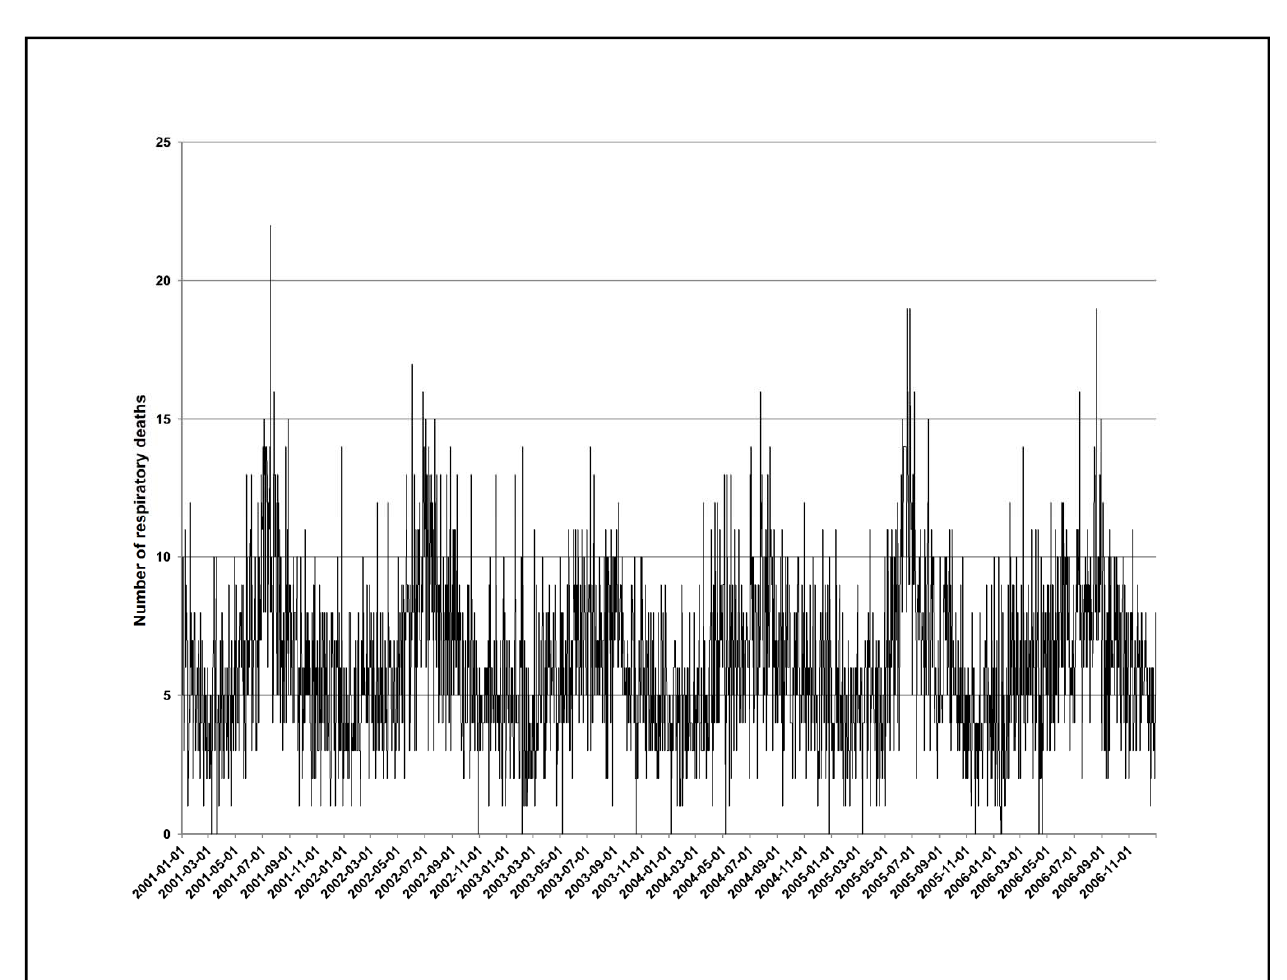
Figure A2. Time series of respiratory ( a ), cardiovascular ( b ) and cerebrovascular mortality ( c ) in Cape Town during 1 January 2001–31 December